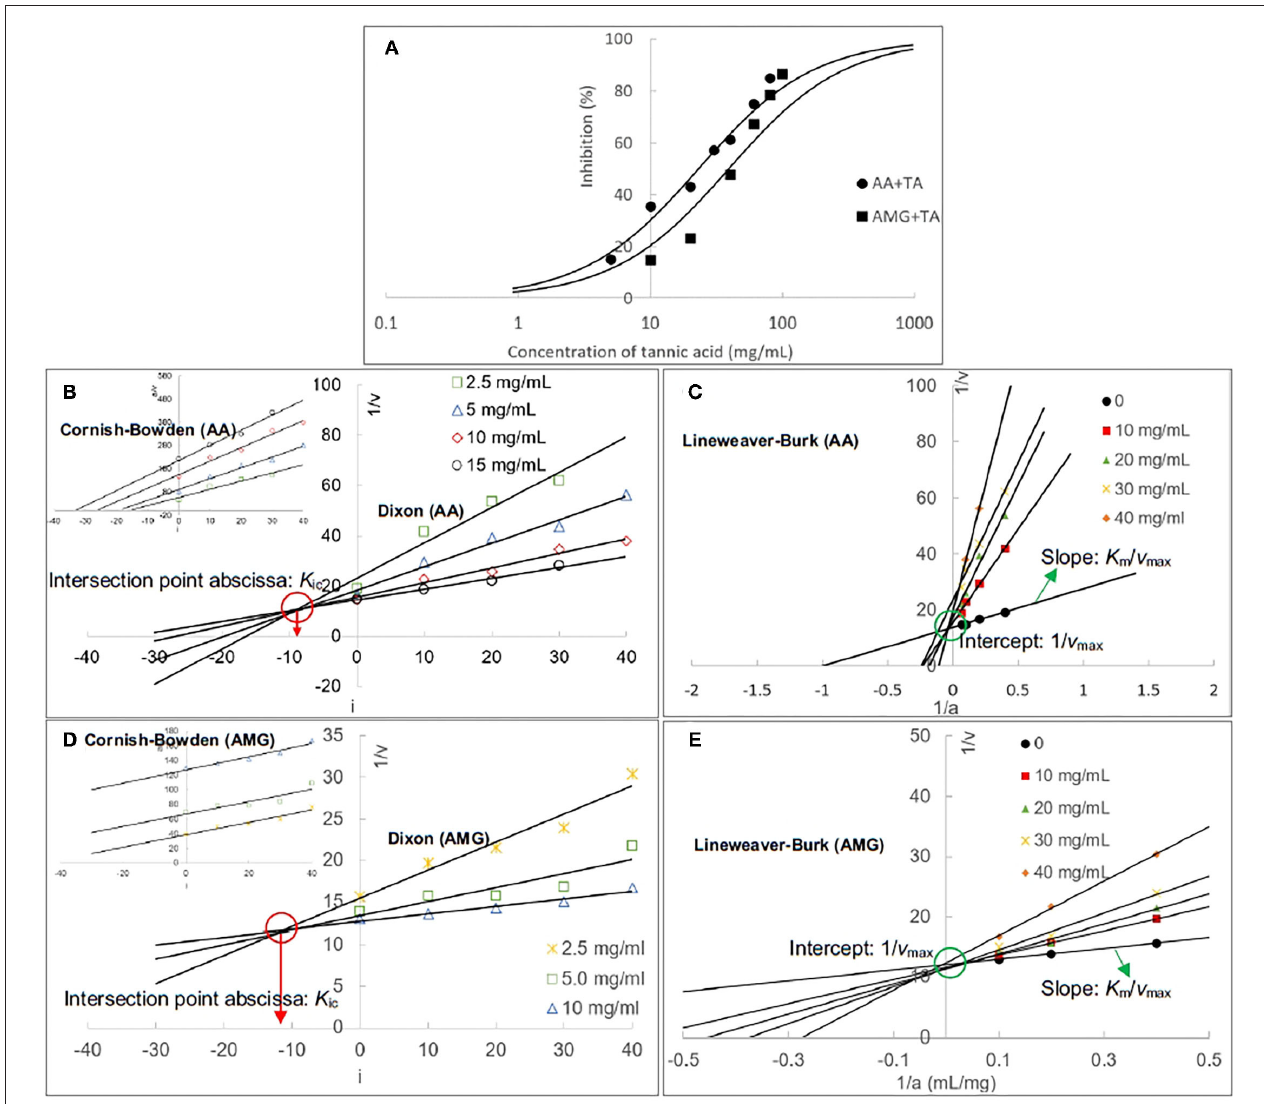
FIGURE 2 | The inhibition of AA and AMG at different TA concentrations (A) ; the inhibition curves were fitted using the half inhibition concentration (IC 50 ) calculating equation. The Dixon and Cornish–Bowden (insert) plots of TA for AA inhibition (B) , and the respective ones for AMG inhibition (D) , in which the absolute value of intersection abscissa in the Dixon plot was calculated as the competitive inhibition constant ( K ic ). The Lineweaver–Burk plots for AA (C) and AMG (E) inhibition, in which the intercept was calculated as the reciprocal of maximum initial reaction velocity (1/ v max ) and the slope was the ratio of Michaelis constant to v max ( K m / v max ).